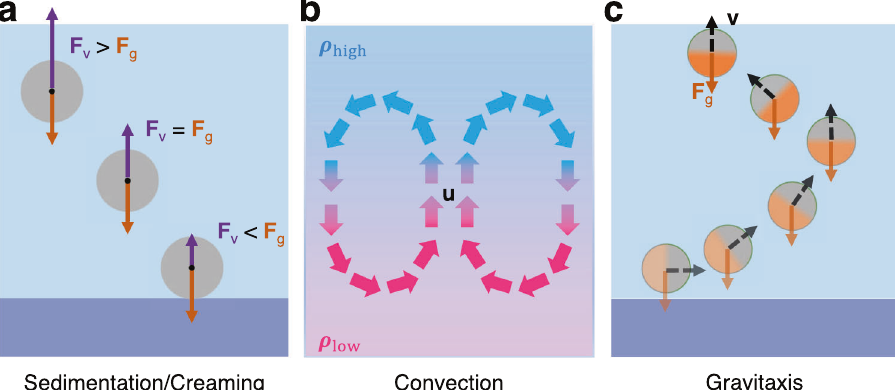
Fig. 2 The effects of gravity on active matter. On Earth, microscopic active matter is affected by gravity in multiple ways. The most relevant ones include: a Sedimentation and creaming, where the balance between the particle ’ s and solvent ’ s densities lead to either an upward or downward motion of the particle in a fl uid. F v and F g represent the viscous force and gravitational force, respectively. b Convection, where fl ow patterns at speed u due to density mismatches of various origin transport matter within the sample. The colour scale represents a gradient of density ρ going from low density ( ρ low ) at the bottom to high density ( ρ high ) at the top. c Gravitaxis, where a motile organism or synthetic particle with self-propulsion speed v moves in a direction in fl uenced by gravitational fi